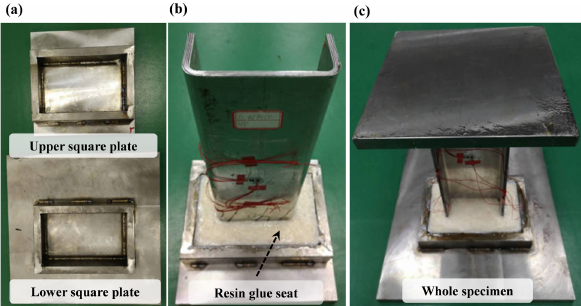
Figure 5: Upper and lower bearing square plates and epoxy resin rubber rigid constraint seats.